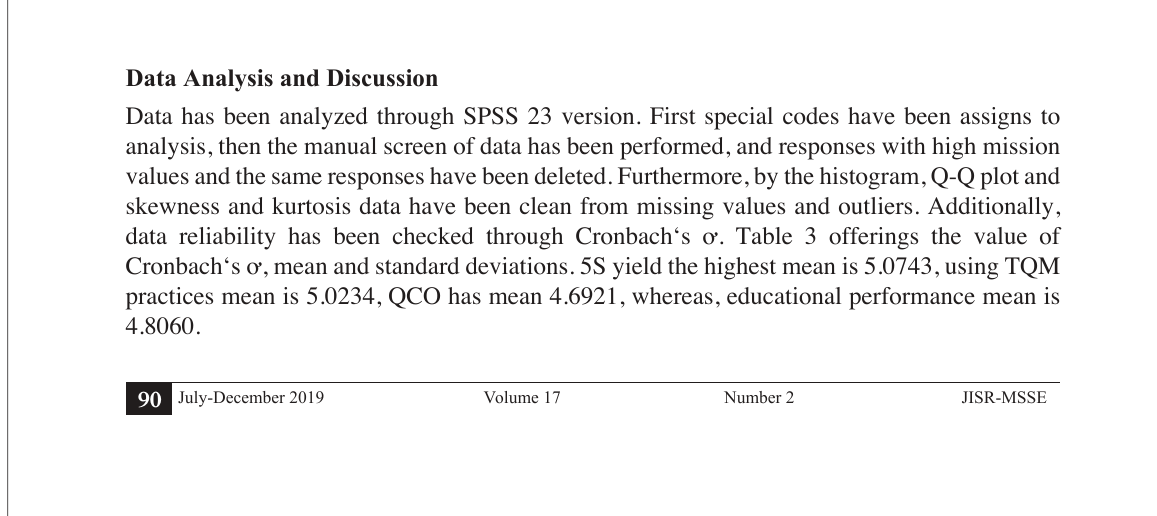
Figure 4: Number of respondents according to their experience and managerial